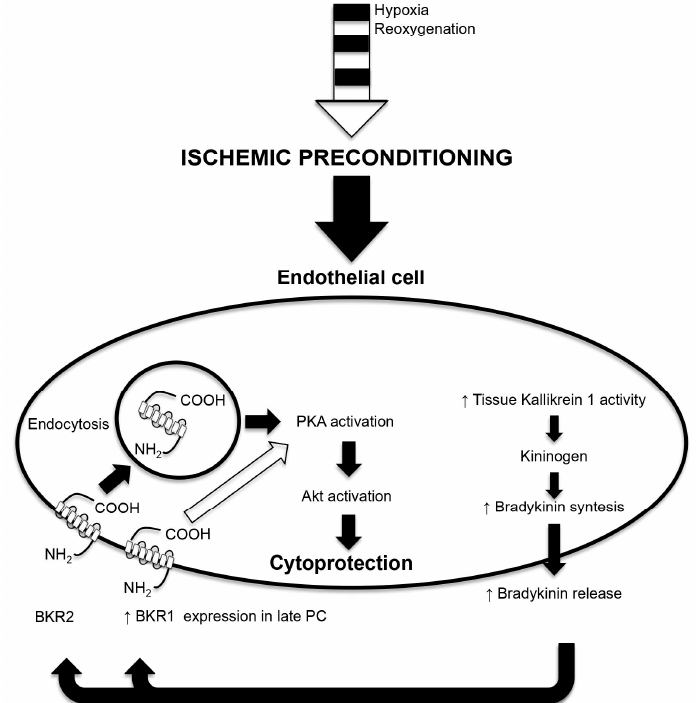
Figure 2. Repeated episodes of hypoxia-reoxygenation enhance the synthesis and the release in the extracellular space of bradykinin (Bk), through an increase of tissue kallikrein 1 (KLK1) activity. The released Bk by an autocrine mechanism binds its receptors. These consist of 2 types of seven transmembrane domain G protein-coupled receptors: type 2 (BKR2), which is constitutively expressed; and type 1 (BKR1), which is not constitutively expressed, but it is up-regulated by late PC. The binding of Bk to BKR2 induces the endocytosis of the receptor; this phenomenon activates protein kinase A (PKA), which, in turn, phosphorylates/activates Akt. This mechanism accounts for the cytoprotective effect of the early and late preconditioning (PC). The binding of Bk to BKR1 through the activation of PKA-Akt accounts for cytoprotection in the late window of PC.